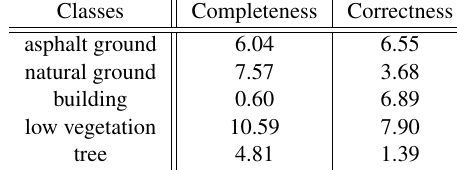
Table 2: Comparison of enhanced CRF results and simpler model (differences of completeness and correctness values).